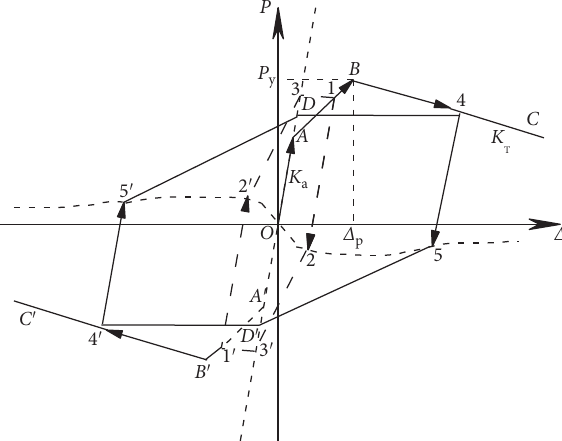
Figure 22: Restoring force model of S-CF-CFRP-ST